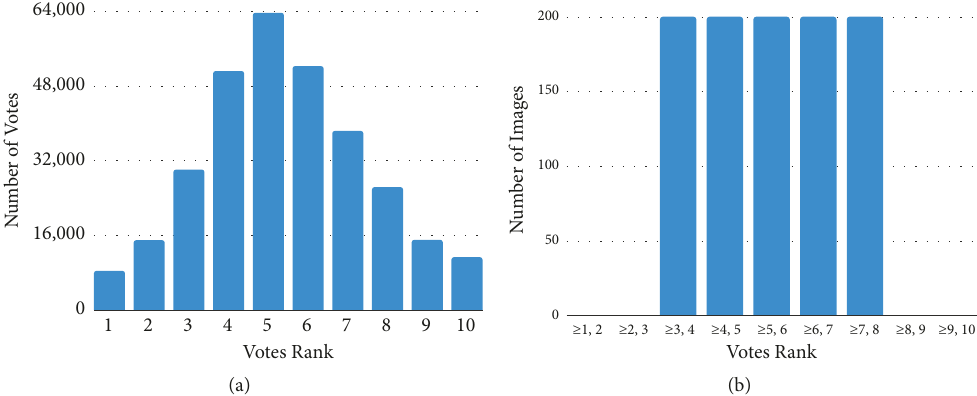
Figure 2: Characterisation of the 1000 images in the proposed set. (a) Distribution of the number of votes within the scoring range and (b) distribution of mean ratings in the images within the valid range of scores.